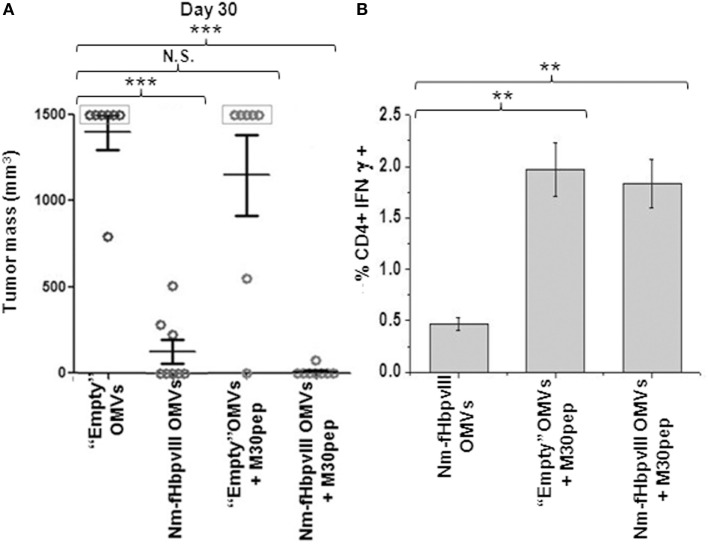
Synergistic protective activity of Nm-fHbpvIII-OMVs/M30 peptide combination. (A) Analysis of tumor development in C57BL/6 mice immunized as shown in Figure 2A. The figure reports the tumor size in each mouse as measured at day 30 after the challenge with 0.5 × 105 B16F10EGFRvIII cells. *** indicates that the difference in tumor size between each group and control group is statistically significant with P < 0.001. (B) Analysis of M30pep-specific CD4+ T cells in immunized mice. At the end of the challenge experiment, spleens from two animals were collected. Splenocytes were stimulated with M30pep and IFNγ-producing CD4+ T cells were analyzed by flow cytometry (**P < 0.01).